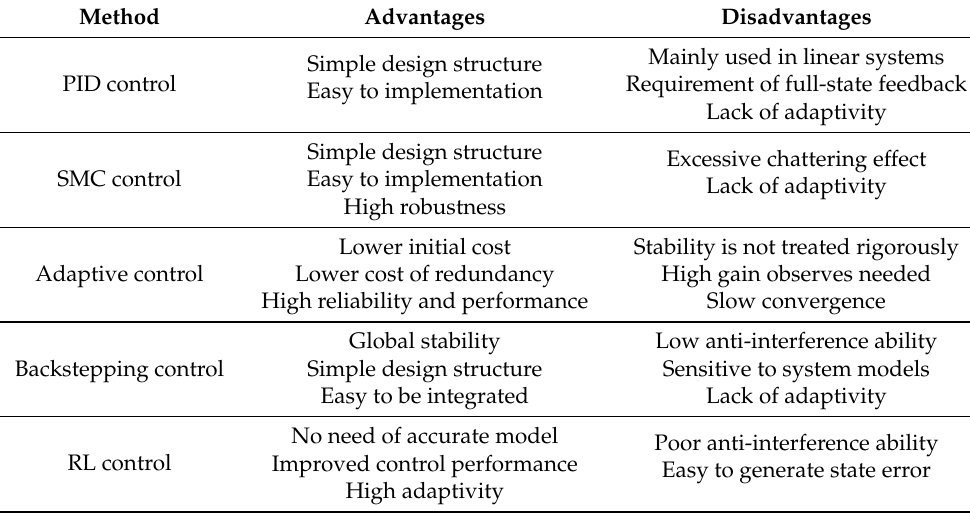
Table 1. Comparison of different control